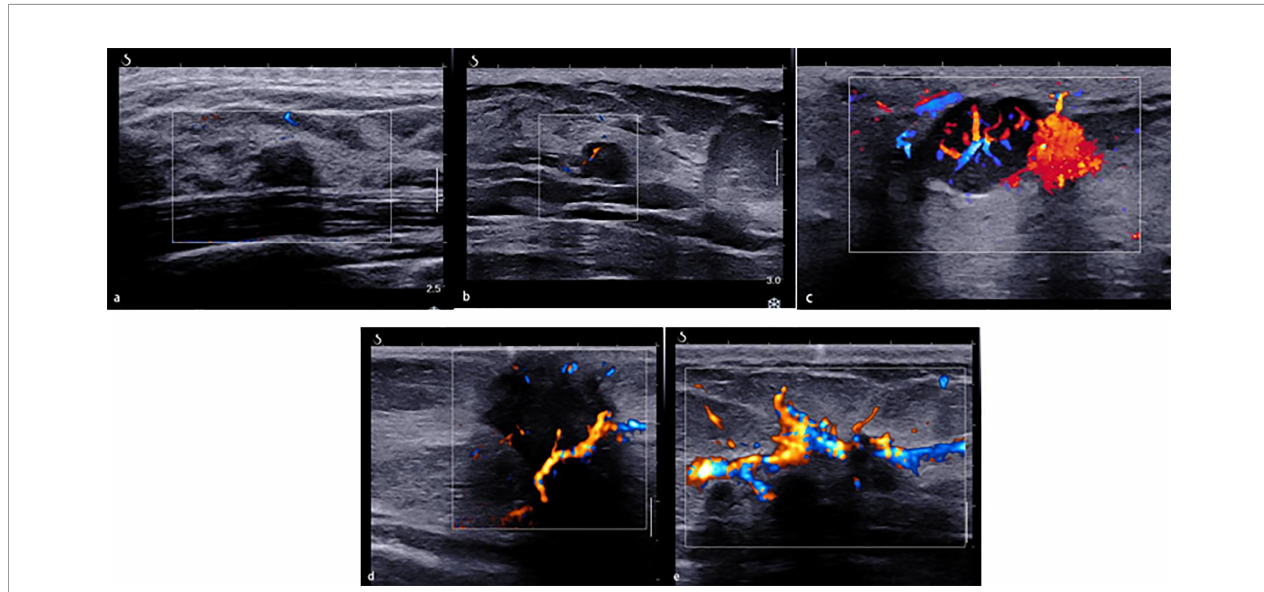
FIGURE 1 | The morphologic and distribution features of Angio PLUS. (A) Non-vascular pattern. (B) A linear or curvilinear pattern. (C) A treelike pattern. (D) A root hair-like pattern. (E) A crab claw-like